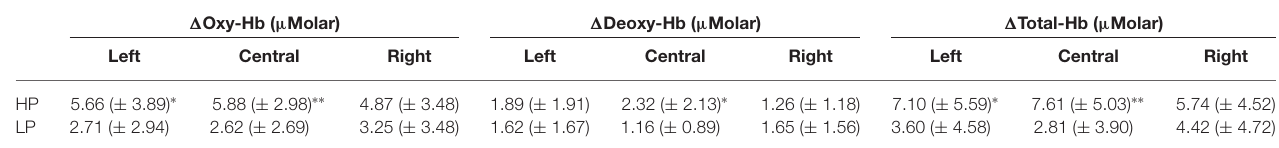
TABLE 3 | Post- and pre-exercise oxy-Hb, deoxy-Hb, and total-Hb changes ( ∆ oxy-Hb, ∆ deoxy-Hb, and ∆ total-Hb) are given for LP and HP groups in all PFC area (mean ± SD). ∆ Oxy-Hb ( µ Molar) ∆ Deoxy-Hb ( µ Molar) ∆ Total-Hb ( µ Molar) Left Central Right Left Central Right Left Central